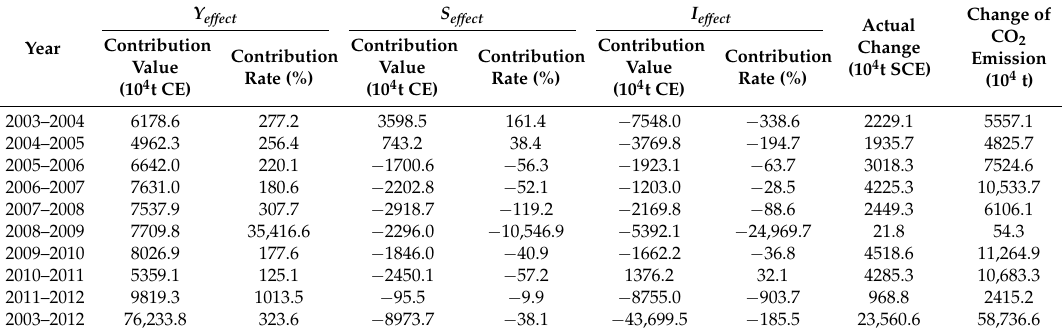
Figure 2. The output value share of top six energy-consuming subsectors in 2003–2012.